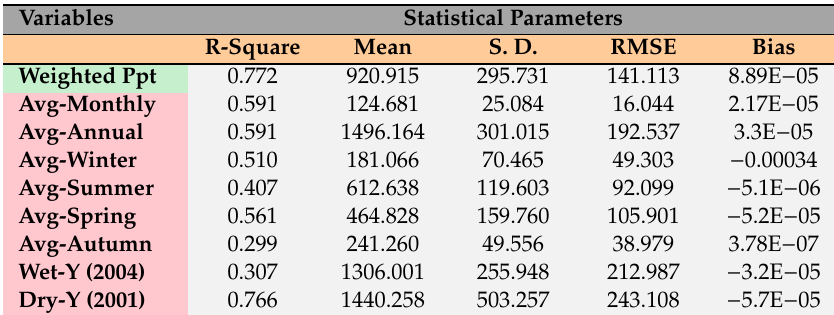
Table 3. Comparison between the weighted precipitation and multitemporal precipitation variables original 0.1 ◦